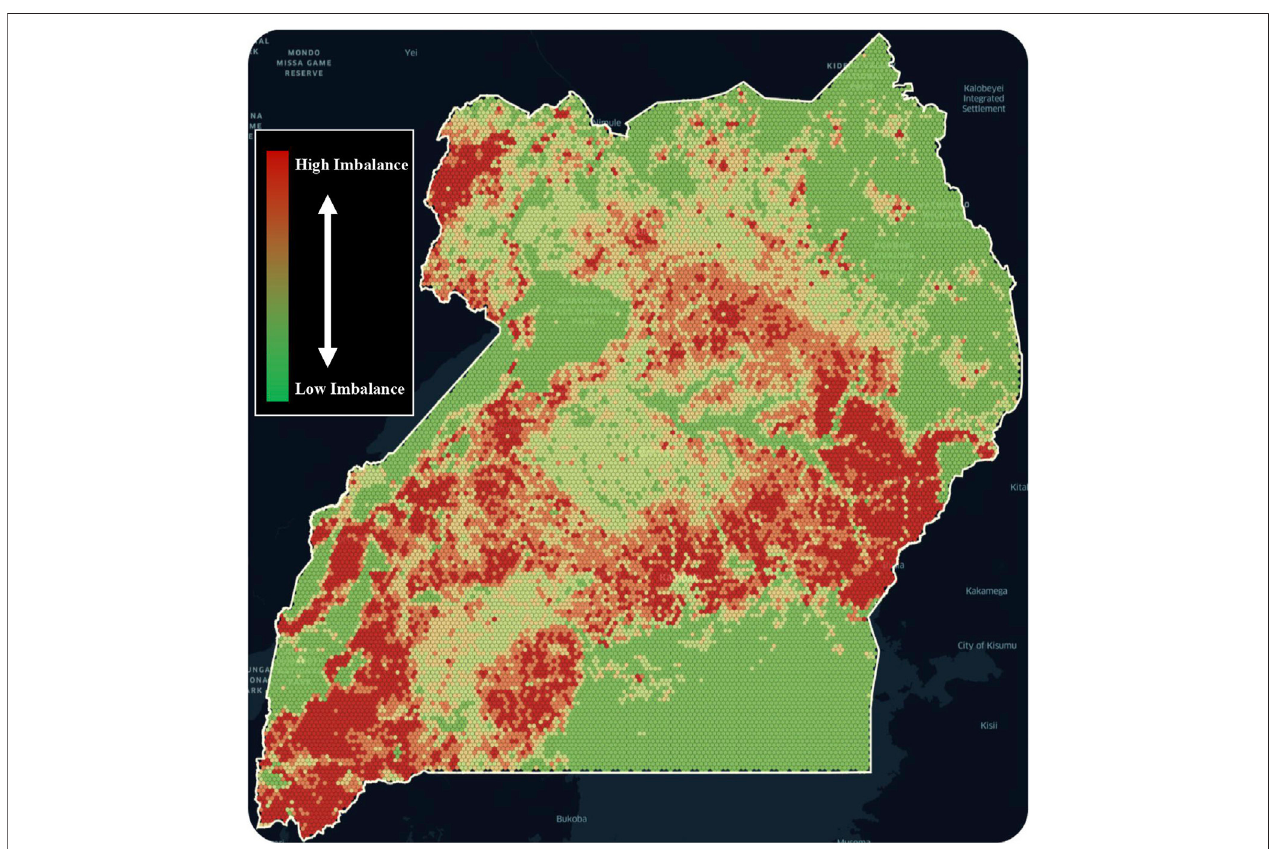
FIGURE 6 | Connectivity imbalance visualization for Uganda, a developing country in the middle of Africa. The whole country is spitted into many small areas, and each area is approximately 4 km 2 , and the imbalance index calculates a ratio of population to the number of BSs for each area.